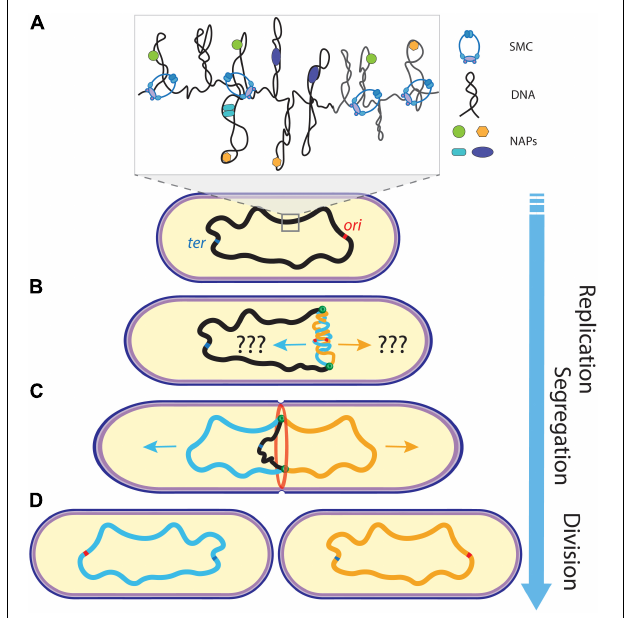
FIGURE 1 | Schematics of chromosome replication and segregation in bacteria. (A) A mother chromosome (black) with an origin (ori) and terminus (ter) of replication site resides in the cell. Inset shows the compacted organization of the chromosome into supercoiled domains organized by NAPs and SMCs. (B) Upon replication initiation at ori, sister chromosomes (blue and orange) are being synthesized by the replisomes (green dots). (C) While the replisomes move bi-directionally along the chromosome arms to further replicate the DNA, the sister chromosomes segregate into opposite cell halves and the cell starts to divide (through the divisome ring shown in red). (D) Ultimately, two daughter cells are formed after cell division, with each containing one copy of the chromosome. Arrow of time runs from top to